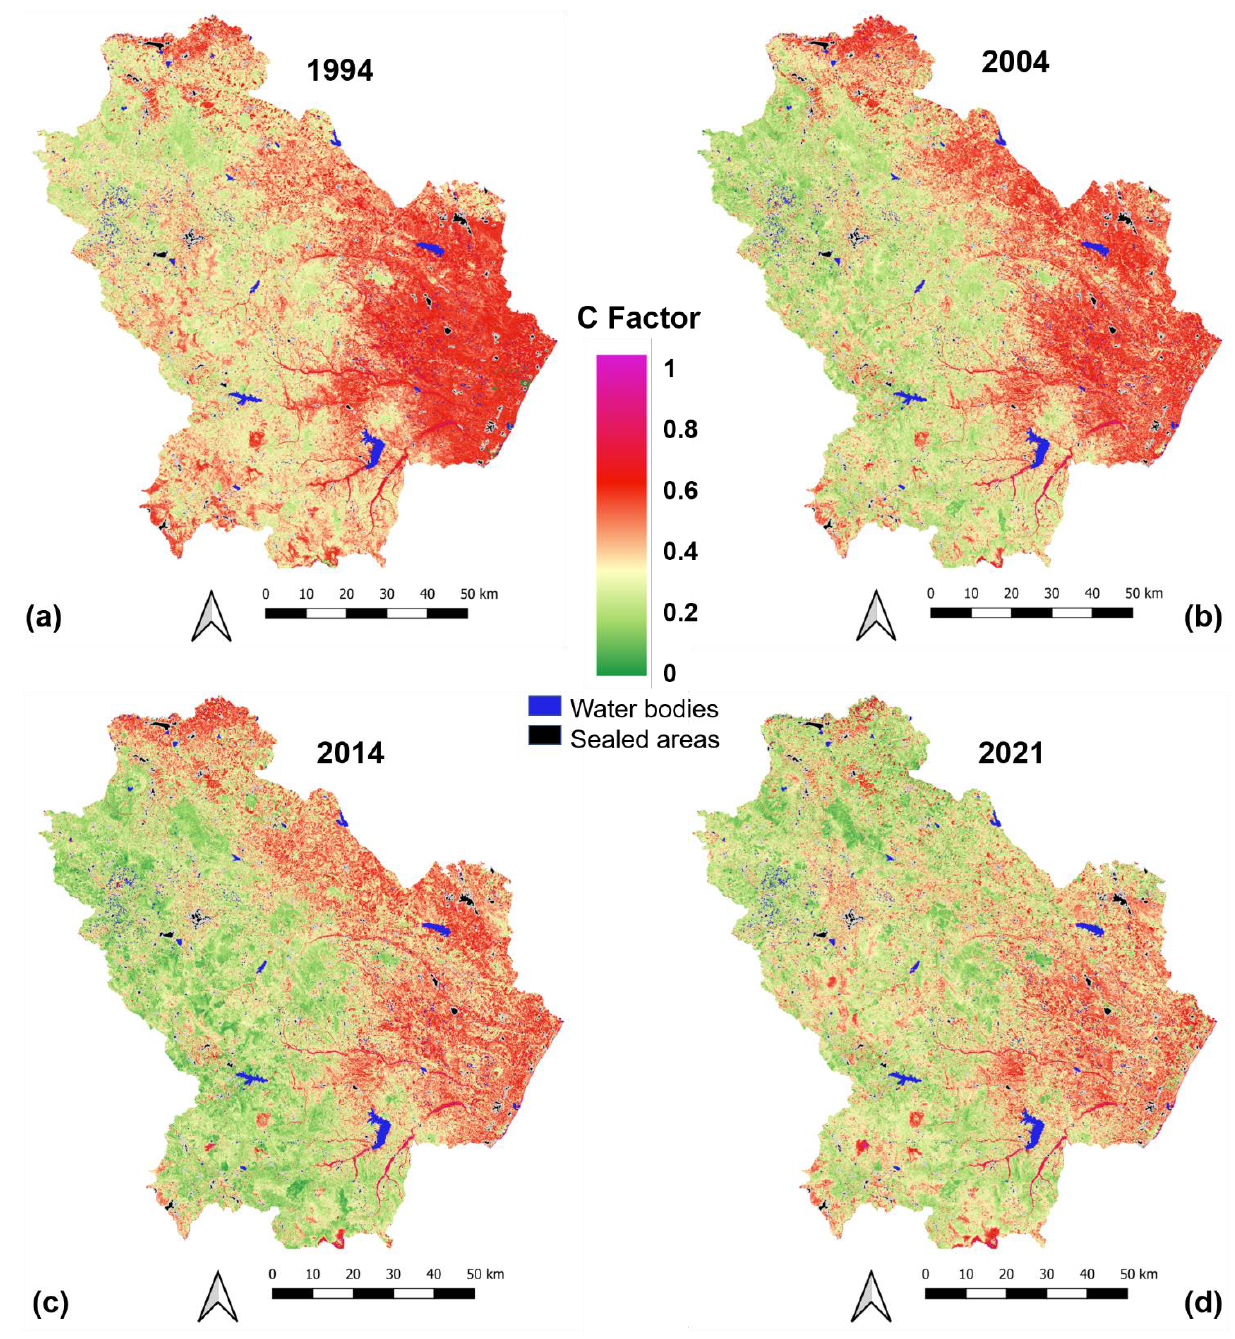
Figure 4. Cover management (C) factor values computed in the analyzed years through satellite image elaborations: ( a ) 1994; ( b ) 2004; ( c ) 2014; ( d ) 2021. The chosen dataset does not consider the surface stone cover and its protective effect against soil erosion. This likely produced an overestimation of soil erosion in our final estimate